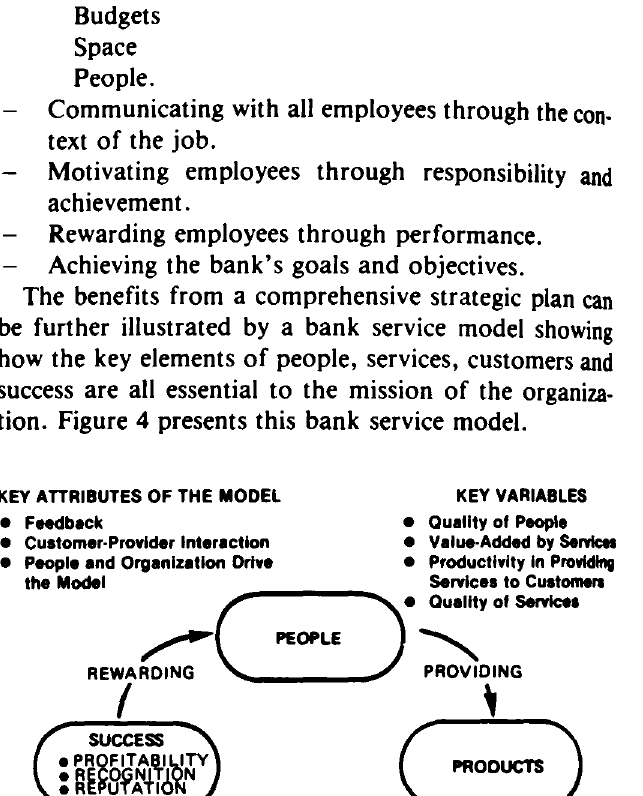
Figure 4 A bank service